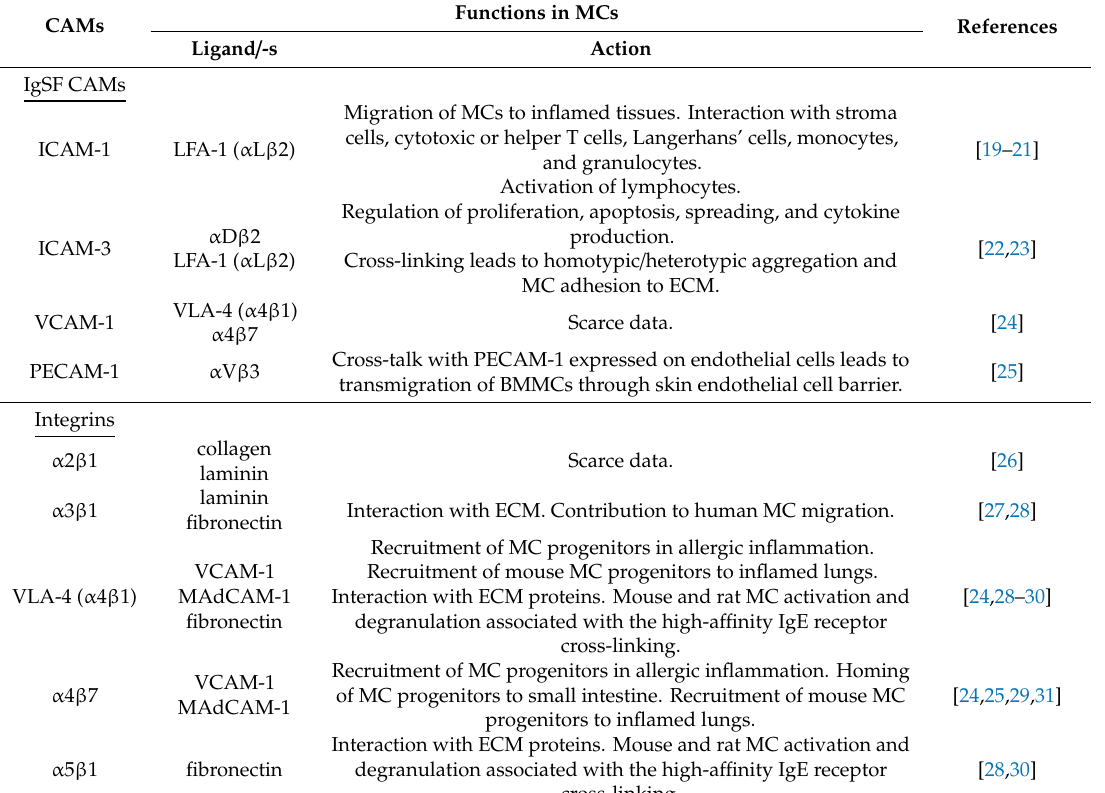
Table 1. Cell adhesion receptor functions in mast cells